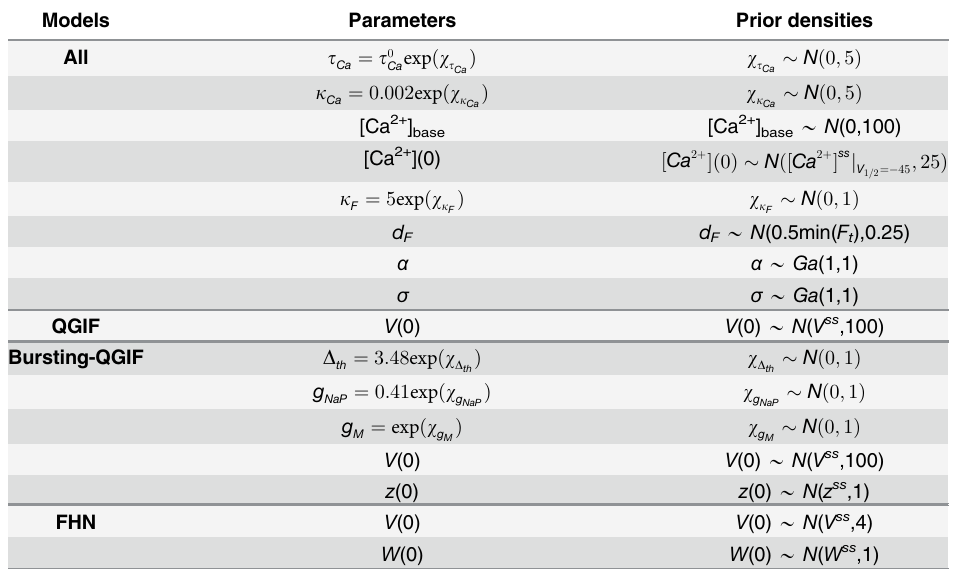
Table 2. Prior densities. Models Parameters Prior